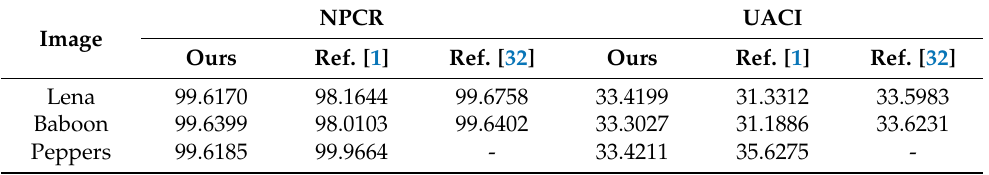
Table 9. Sensitivity of different method for a single pixel change of the original